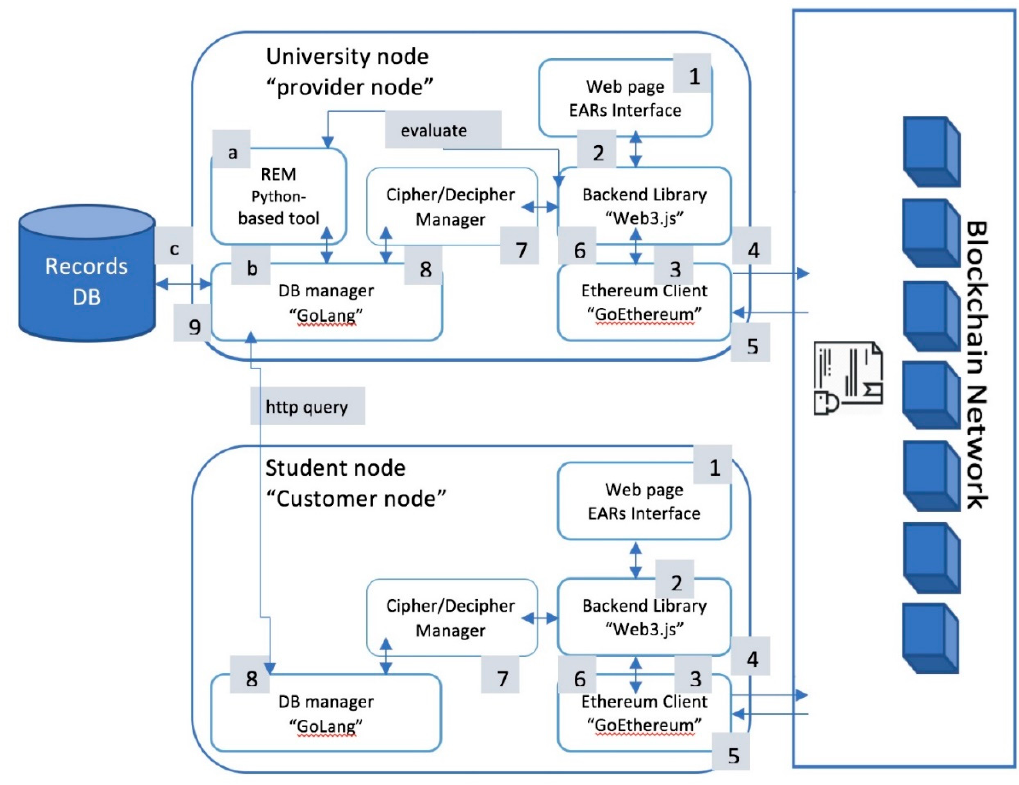
Figure 1. Software Components of the UniChain System.